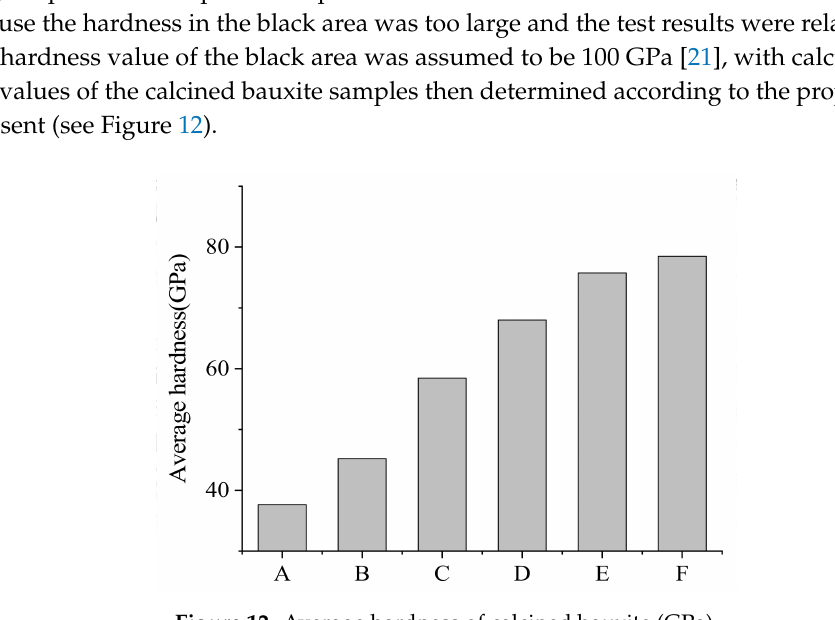
Figure 12. Average hardness of calcined bauxite